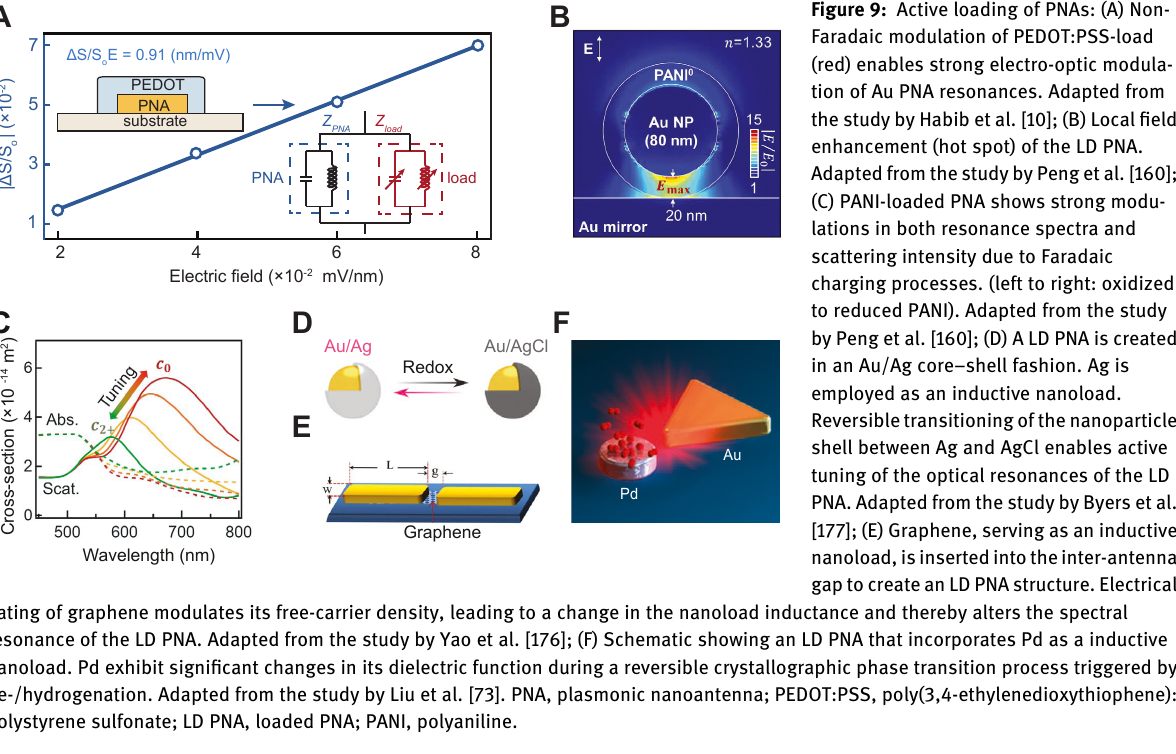
Figure 9: Active loading of PNAs: (A) Non- Faradaic modulation of PEDOT:PSS-load (red) enables strong electro-optic modula- tion of Au PNA resonances. Adapted from the study by Habib et al. [10]; (B) Local fi eld enhancement (hot spot) of the LD